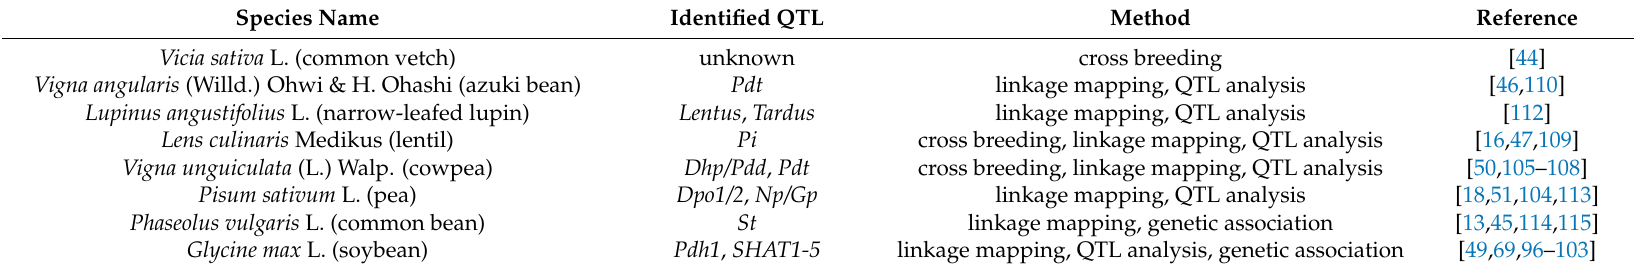
Table 1. Pod Shattering QTL in